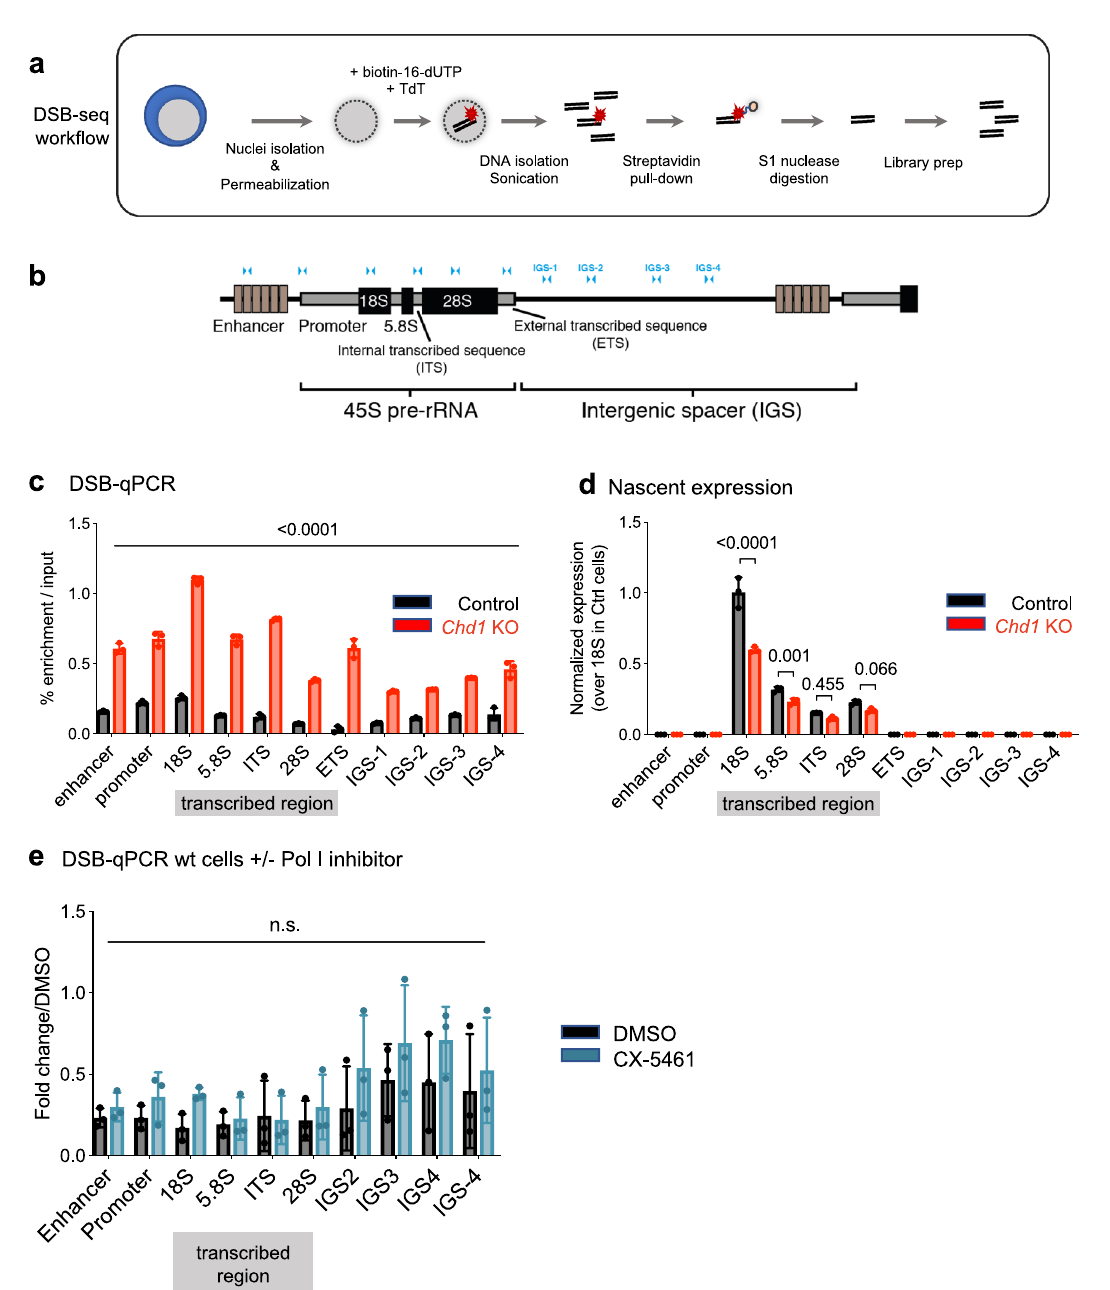
Fig. 3 Double-stranded breaks accumulate at ribosomal DNA in Chd1 KO cells. a Schematic depiction of the work fl ow of DSB-PCR/seq. TdT terminal deoxynucleotidyl transferase, DSB double-stranded break. b Schematic depiction of one rDNA transcription unit. c DSB levels along the rDNA unit in control and Chd1 KO cells, normalized to input. N = 3 biologically independent experiments. Graphs show mean and standard deviation. Statistical tests performed are two-way ANOVA with Sidak ’ s correction. Values above bars indicate p -values. d Nascent rRNA transcription in control and Chd1 KO cells. N = 3 biologically independent experiments. Graphs show mean and standard deviation. Statistical tests performed are two-way ANOVA with Sidak ’ s correction. Values above bars indicate p -values. e DSB levels in wt ES cells with or without treatment with a Pol I inhibitor. N = 3 biologically independent experiments. Graphs show mean and standard deviation. Statistical tests performed are two-way ANOVA with Sidak ’ s correction. Values above bars indicate p